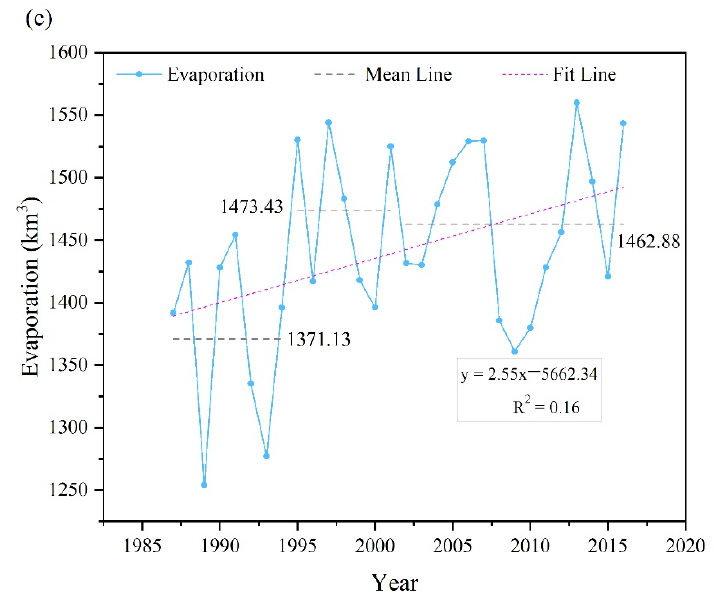
Figure 7. The changes in precipitation, temperature and evaporation of the Hala Lake Basin from 1987 to 2018.